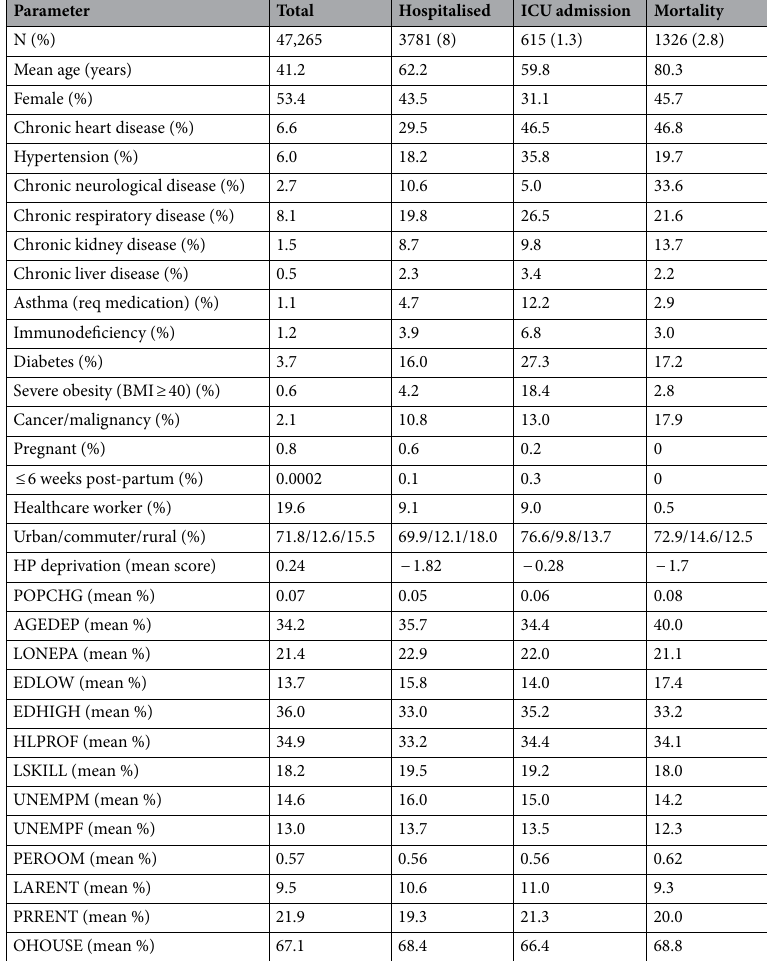
Table 2. Clinical characteristics of symptomatic COVID-19 cases—demographics, comorbidities, mean deprivation scores, and outcomes, February to November